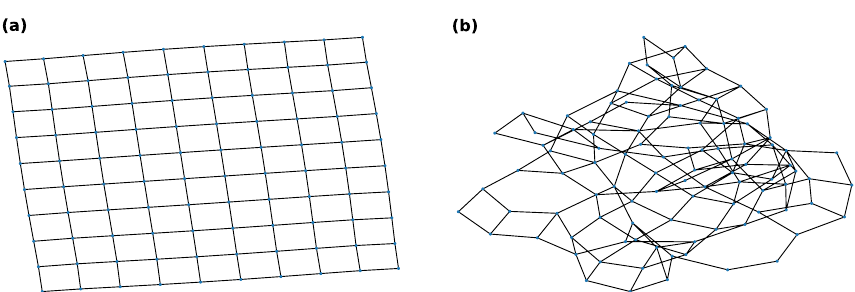
Fig. 10 Illustration of the LSwTM for a p = 0 , b p = 0.1 , using a 10 × 10 lattice as the initial graph. Subfigure a is from the work of Zakar‑Polyák et al. (2022a)